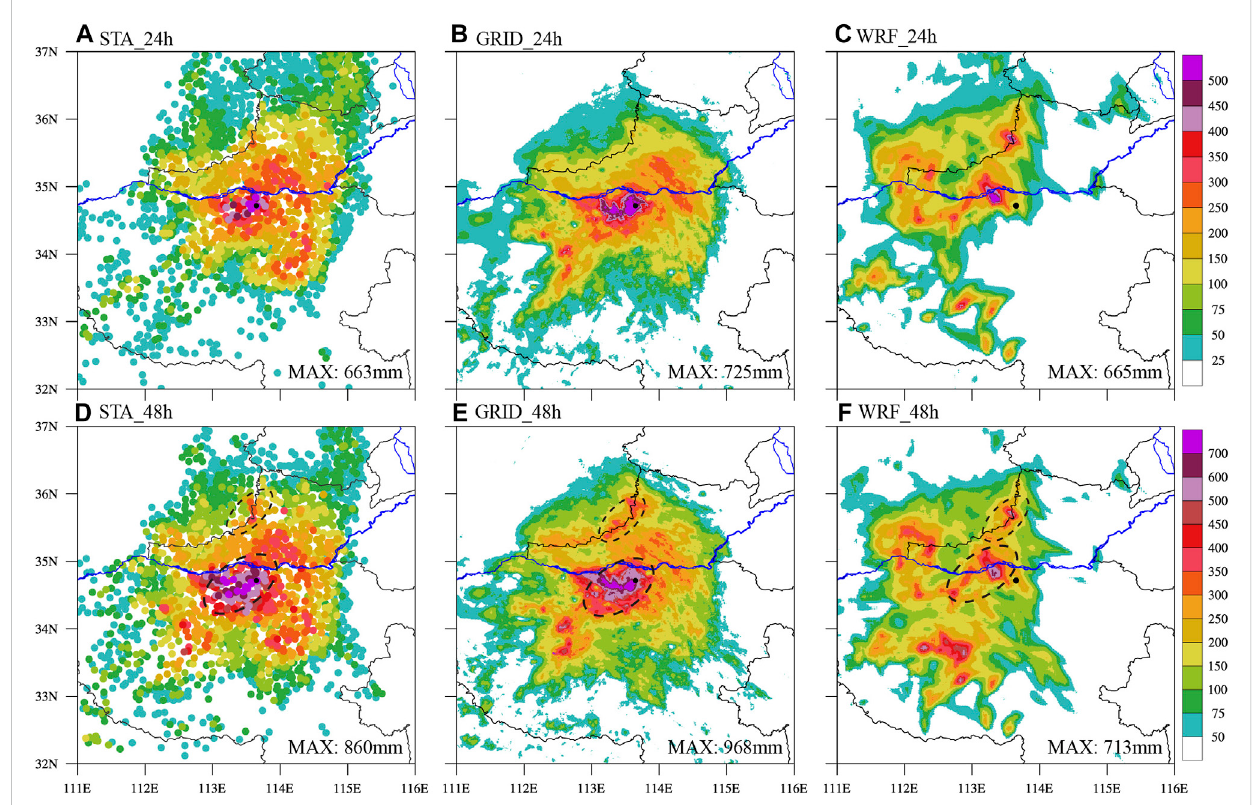
pointprecipitationfromtheChinaMeteorologicalAdministrationobservations (C,F) Simulatedprecipitationdistributionofcontroltest.Theblackdashed circle represents the main rain belt. The black dot represents the location of